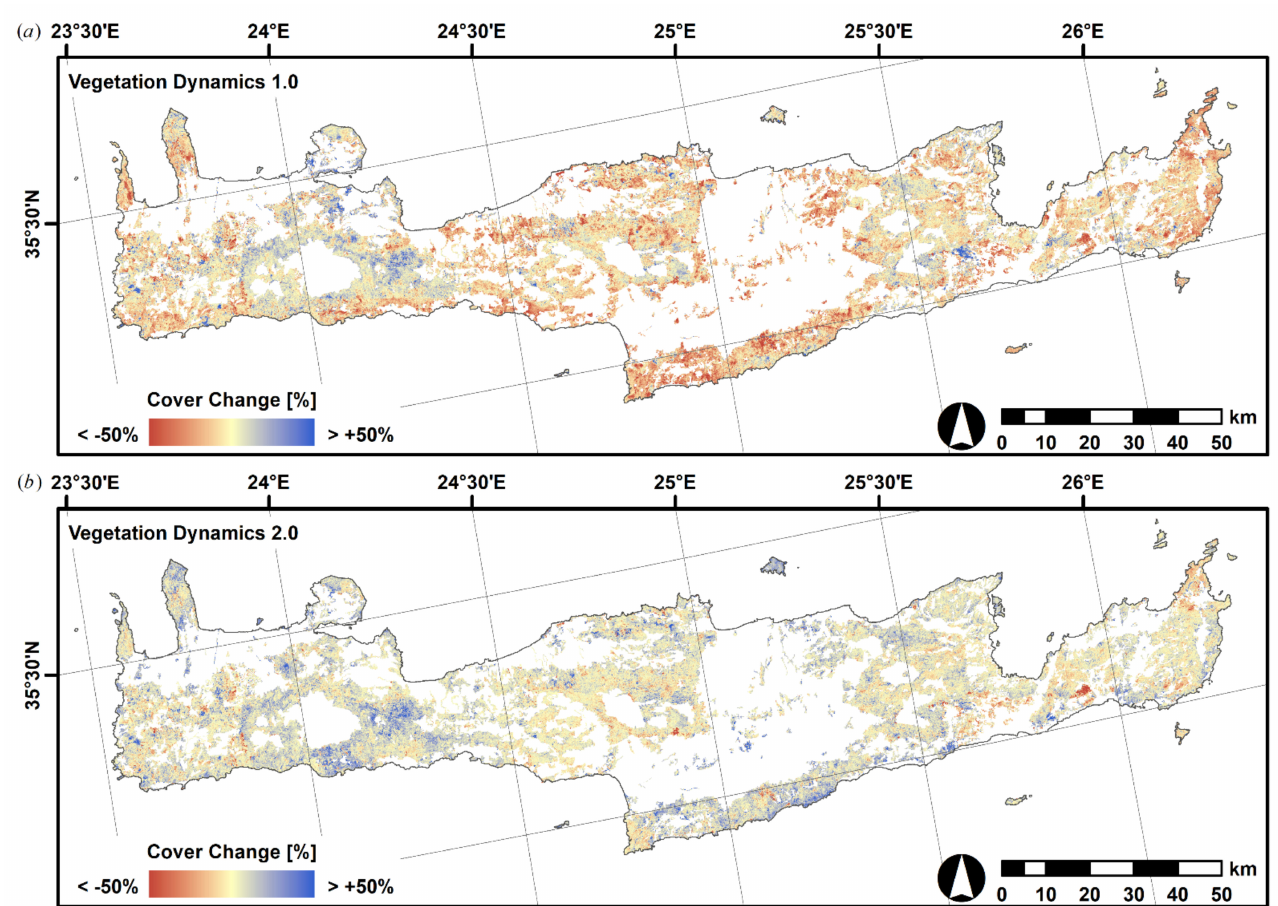
Figure 5. Cover change for the Vegetation Dynamics 1.0 ( a ) and Vegetation Dynamics 2.0 ( b ) analyses over the study period 1984–2006. White areas are non-natural areas or above 1500 m a.s.l., which were out of scope of this